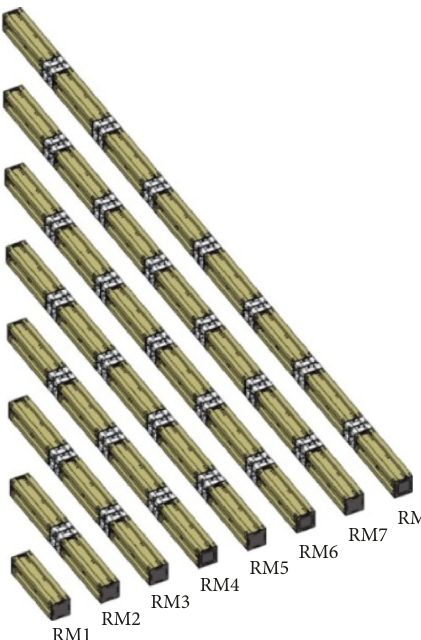
Figure 9: Modulated series of the 10 resistant members proposed by the flexible structural system (RMn): RM1, RM2, RM3, RM4, RM5, RM6, RM7, and